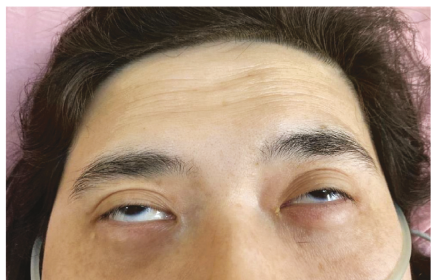
Figure 1: Bilateral partial ptosis with overaction of the frontalis muscle.